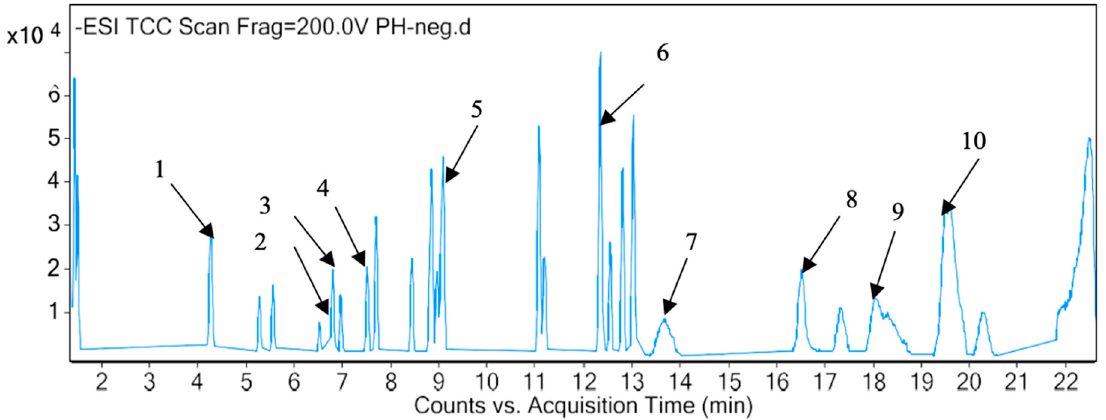
Figure 2. LC-MS chromatograms chemical compounds of P. hysterophorus in the negative ion mode (1. Quinic acid, 2. hymonoxynin, 3. chlorogenic acid, 4. isochlorogenic acid, 5. laciniatin, 6. Rishitin, 7. 4-dodecylbenzenesulfonic acid, 8. lauryl sulfate, 9. tridecyl-benzenesulfonic acid, 10. 4-undecyl benzene sulfonic acid).